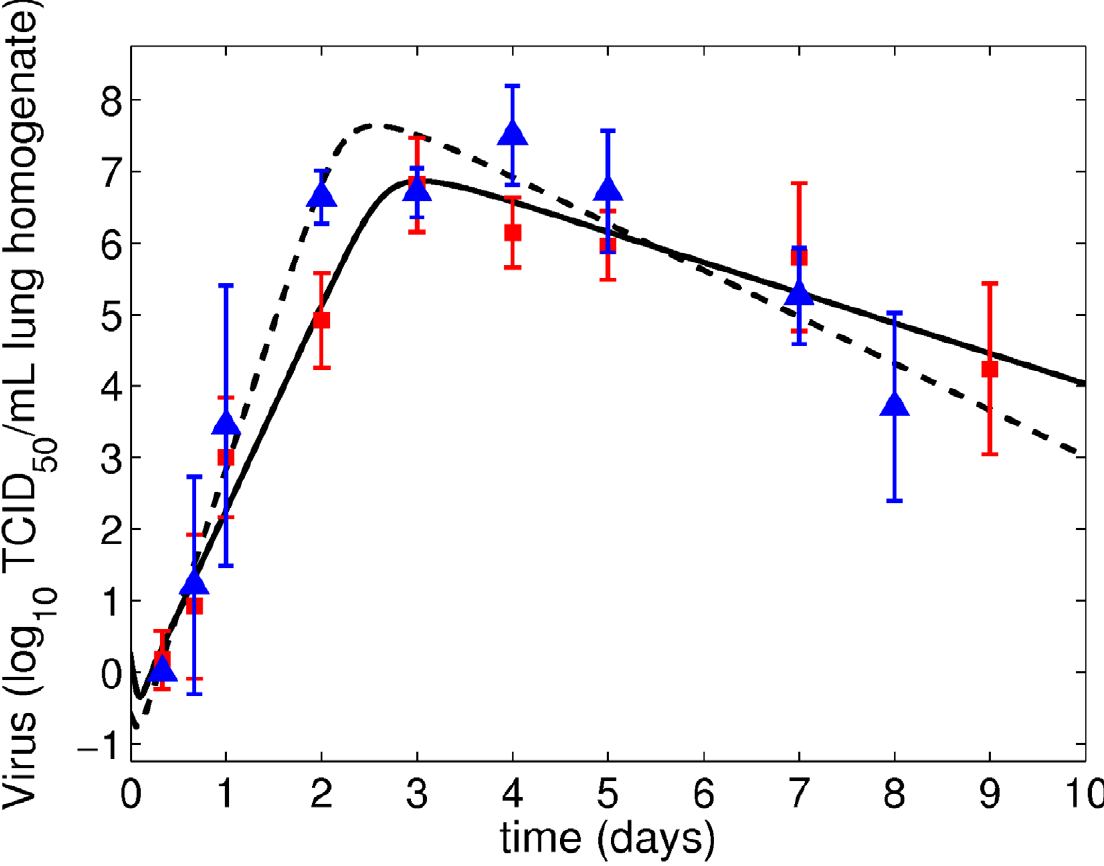
Figure 3. Maximum likelihood fits of the viral kinetic model (Equations (4)–(7)) to lung titers from individual mice infected with the PR8 virus (solid line, squares) or the PR8-PB1-F2(1918) virus (dashed line, triangles).